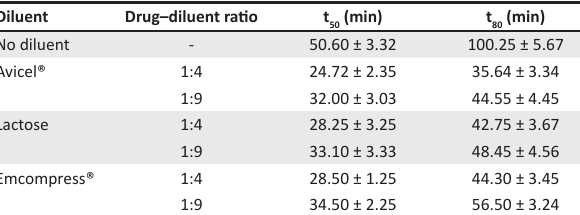
disintegration efficiency ratio (mean ± SD, n = 3). Diluent Drug–diluent